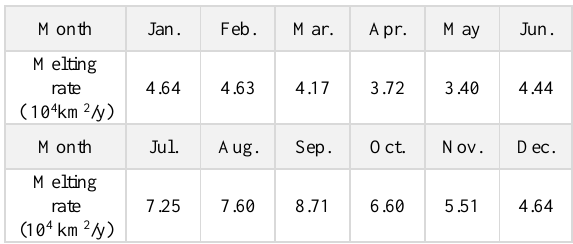
Table 1. Monthly melting rate of sea ice extent in Arctic from 1979 to 2016